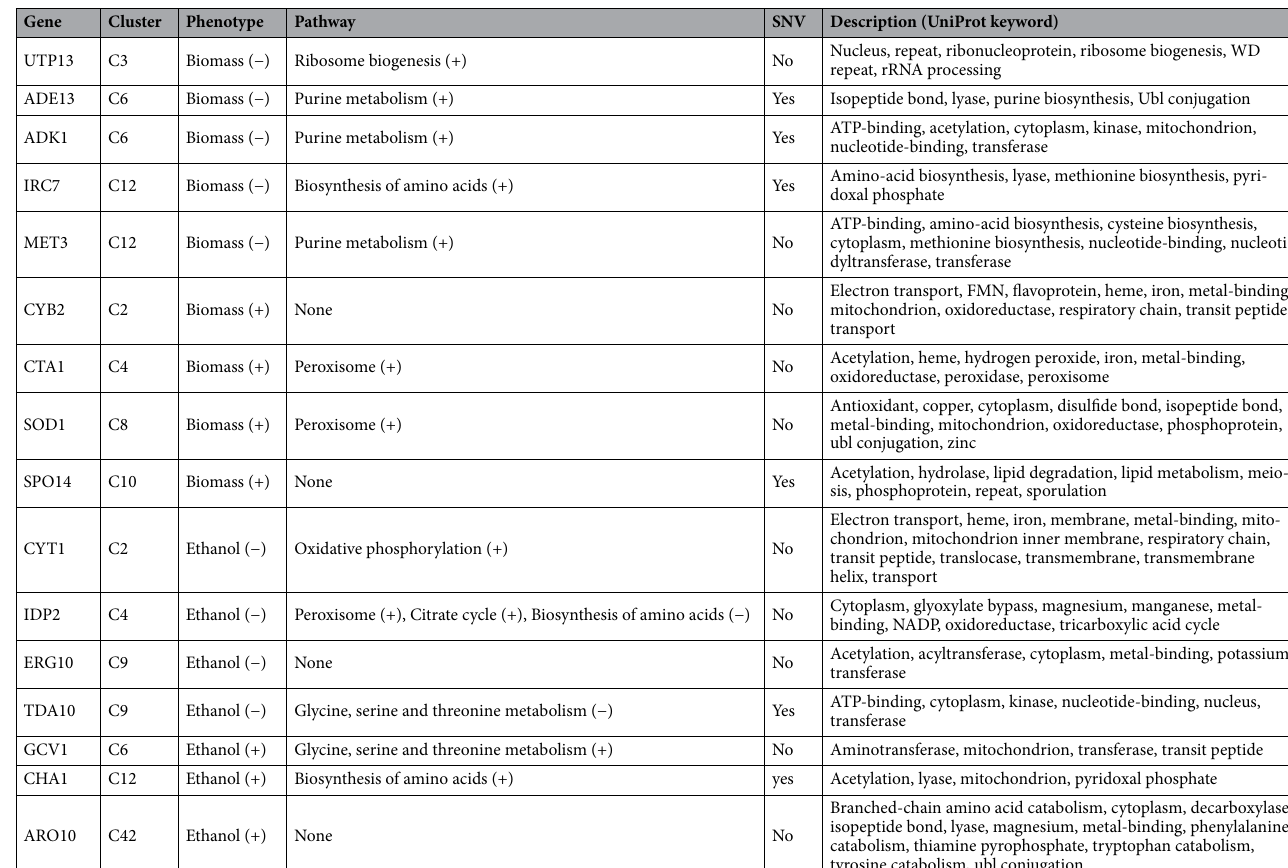
Table 2. List of genes that were used as nodes in the multi-omics